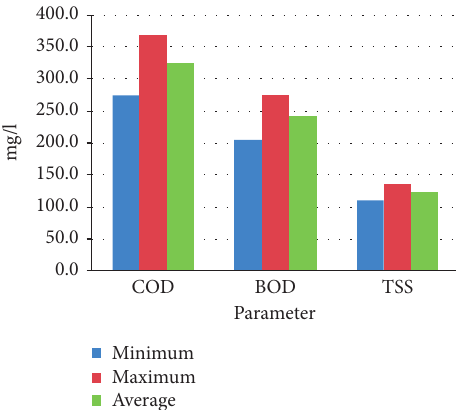
Figure 1: Characteristic of raw sewage water COD, BOD, and TSS.